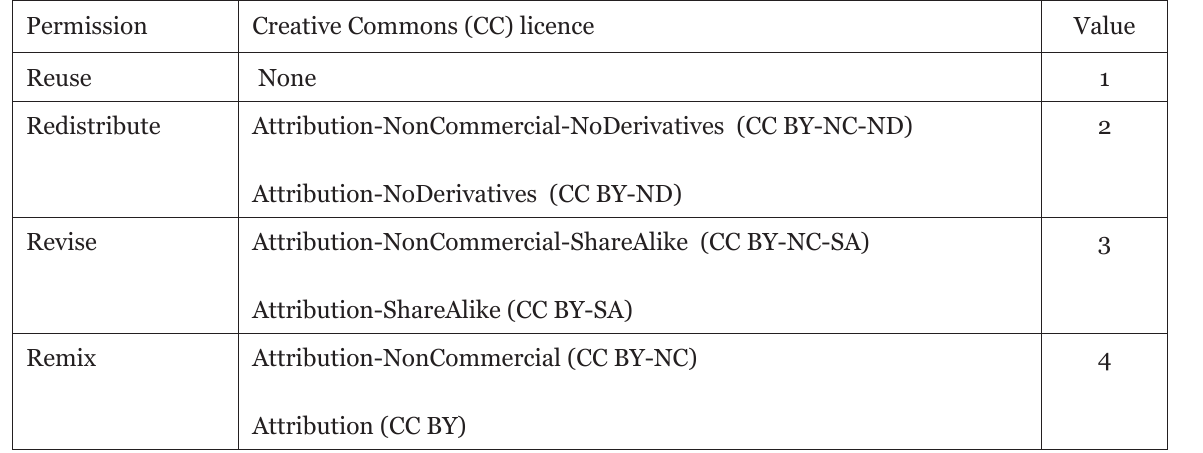
Mapping the CC Licences to the 4